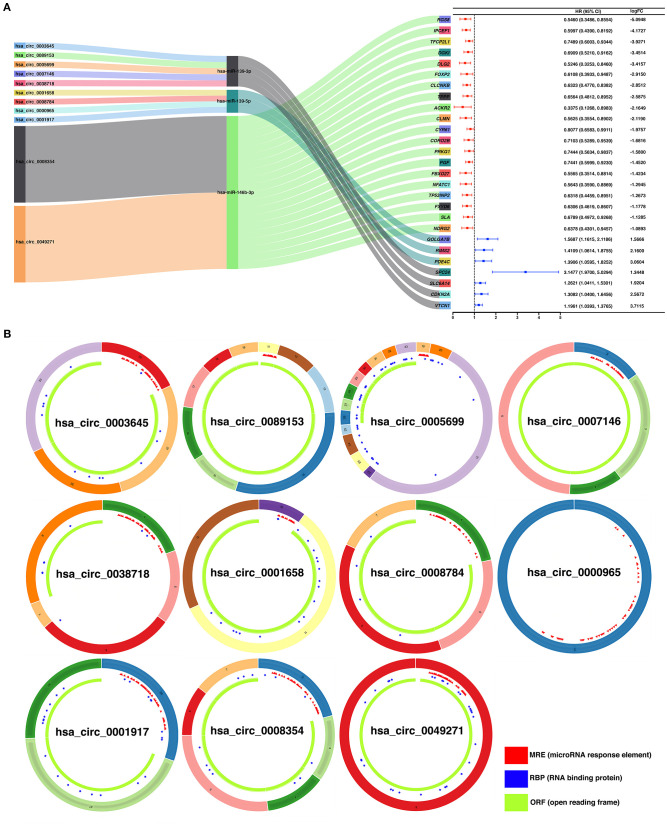
Construction of a ceRNA regulatory subnetwork associated with progression-free interval (PFI) in PTC. (A) The Sankey diagram presents the regulatory relationship within the ceRNA regulatory subnetwork associated with PFI in PTC (left). Forest plot of hazard ratio (HR) presenting the prognostic value of the PFI-related DE-mRNAs within the ceRNA subnetwork and the corresponding logFC values for differential expression (PTC vs. normal) (right). (B) Basic structures of the 11 DE-circRNAs within the ceRNA subnetwork. The structural patterns of hsa_circ_0003645, hsa_circ_0089153, hsa_circ_0005699, hsa_circ_0007146, hsa_circ_0038718, hsa_circ_0001658, hsa_circ_0008784, hsa_circ_0000965, hsa_circ_0001917, hsa_circ_0008354, and hsa_circ_0049271 provided by Cancer-Specific CircRNA Database (CSCD) are shown. The microRNA response element (MRE) is presented in red. The RNA-binding protein (RBP) is presented in blue and the open reading frame (ORF) is presented in green.